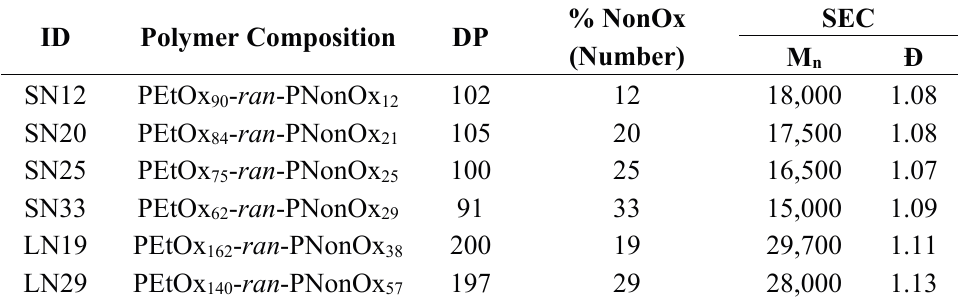
Table 1. Composition and size exclusion chromatography (SEC) data of the synthesized PEtOx n - ran -PNonOx m random copolymers. Polymer composition was calculated by 1 H-NMR analysis. SEC eluent: N , N -dimethylacetamide containing 50 mM LiCl. Calibrated against PMMA standards. Polymer ID legend: S = Short polymer, DP ≈ 100, L = Long polymer DP ≈